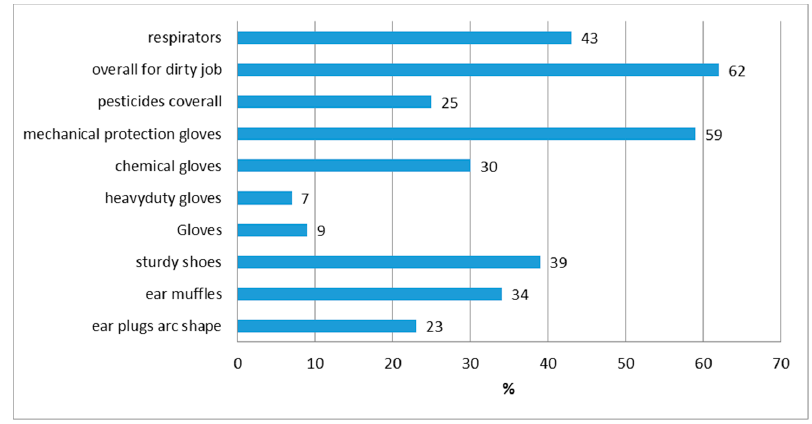
Figure 3. Types of personal protective equipment (PPE) provided at the farms (% of farms where present).